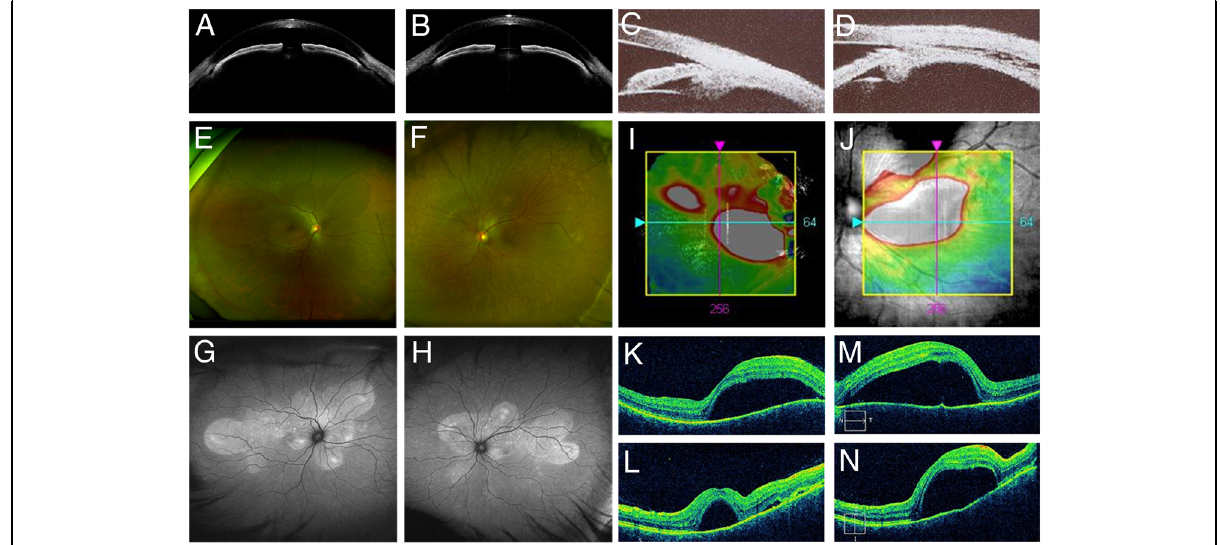
Fig. 1 Baseline findings. a , b Anterior segment optical coherence tomography findings. a Right eye. b Left eye. The anterior chamber was shallow, and the angle was narrow in both eyes. The depth of the anterior chamber was 1.42 and 1.65 mm in the right and the left eyes, respectively ( a – b ). c , d Ultrasound biomicroscopy findings. c Right eye. d Left eye. A ciliochoroidal detachment was observed in the left eye ( d ). e , f Fundus photography findings. e Right eye. f Left eye. Multiple serous retinal detachments were observed in both eyes. g , h Fundus autofluorescence findings. g Right eye. h Left eye. Hyperautoflurescence consistent with the serous retinal detachments were observed in both eyes. i – n Optical coherence tomography findings. i , j Color map. k , m Horizontal. l , n Vertical images. i , k , l Right eye. j , m , n Left eye. Multiple serous retinal detachments were observed in both